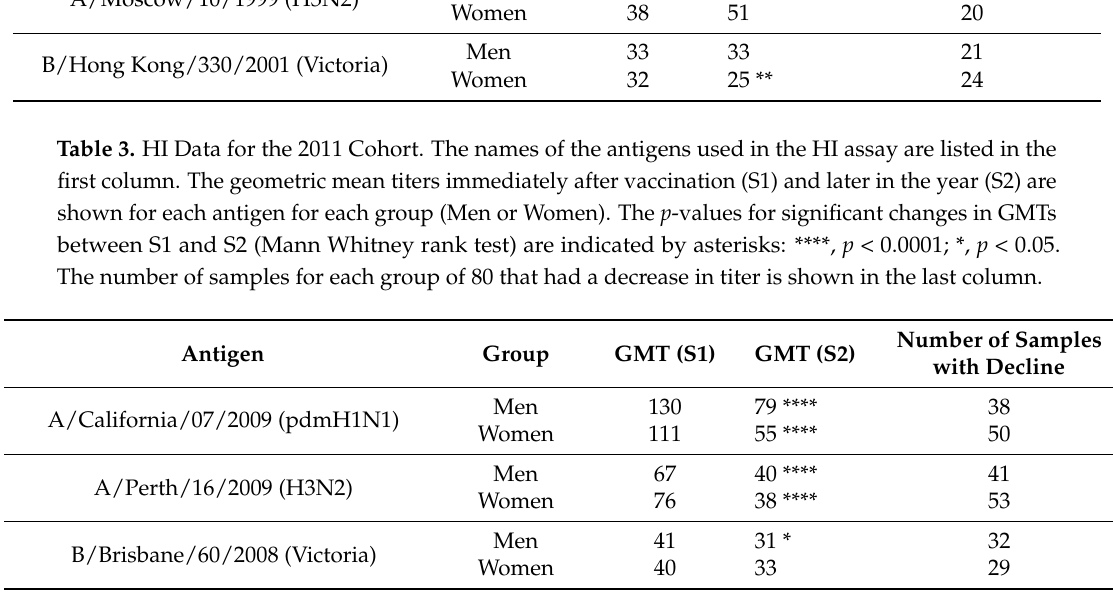
Table 2. HI Data for the 2003 Cohort. The names of the antigens used in the HI (Hemagglutination Inhibition) assay are listed in the first column. The geometric mean titers immediately after vaccination (S1) and later in the year (S2) are shown for each antigen for each group (Men or Women). The p -values for significant changes in GMTs between S1 and S2 (Mann Whitney rank test) are indicated by asterisks: **, p < 0.01. The number of samples for each group of 80 that had a decrease in titer is shown in the last column. Antigen Group